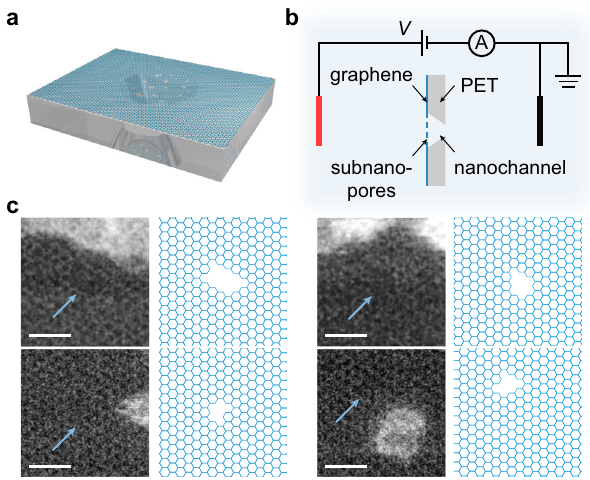
Fig. 1 | Structure of graphene-based polyethylene terephthalate nanochannel (GPETNC) and experimental setup. a Three-dimensional structural model of the GPETNC membrane, which consisted of nanoporous monolayer graphene and polyethylene terephthalate membrane with a conically shaped nanochannel. b Cross-sectional schematic illustration of the GPETNC immersed in electrolyte solutions while measuring ion currents under different applied voltages using Ag/ AgCl electrodes. The graphene with subnanopores was on the base side of the polyethylene terephthalate nanochannel. c Cs-corrected high-angle annular dark fi eld-scanning transmission electron microscopy (HAADF-STEM) images of repre- sentative graphene subnanopores fabricated under ion irradiation. The pores are indicatedbybluearrows,andtheircorrespondingatomicstructuresareillustrated in the right panels. Scale bars are 1